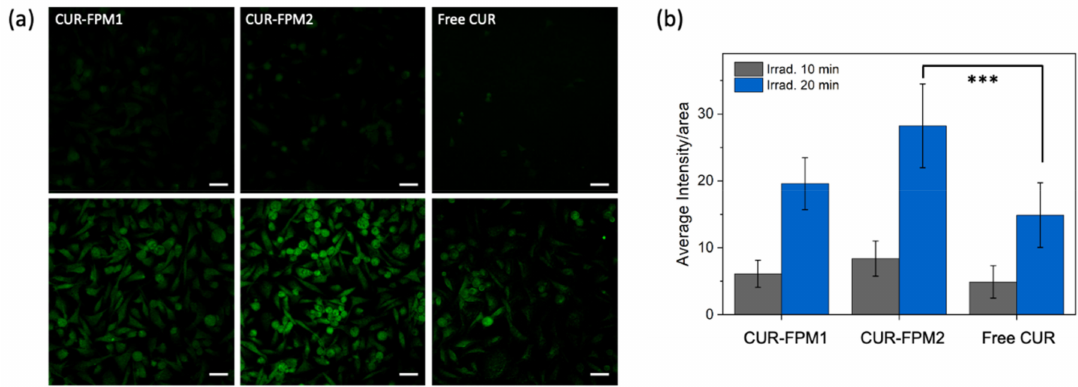
Figure 3. ( a ) CLSM images of HeLa cells treated with CUR-FPM1, CUR-FPM2 micelles, and free CUR under light irradiation (0.04 W / cm 2 ) for ROS detection using DCFH-DA. Top row: irradiation for 10 min. Bottom row: irradiation for 20 min. Scale bar: 25 µ m. ( b ) Average DCF fluorescence intensity per area of the CLSM images in each sample, analyzed by the ImageJ software. Data are presented as mean ± standard deviation. p values: *** p < 0.001, significance